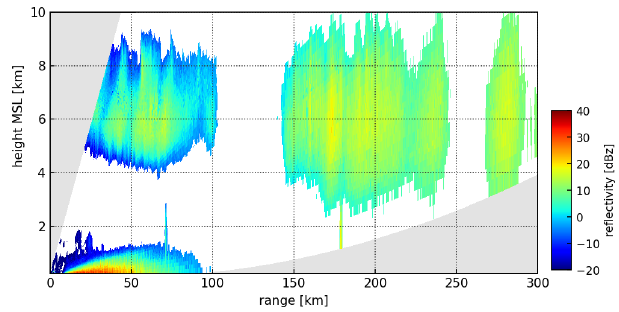
Figure 15. RHI scan on 15 February 2020 at 22:40UTC towards 105 ◦ . Note that the shallow layer up to 95km in range is sea